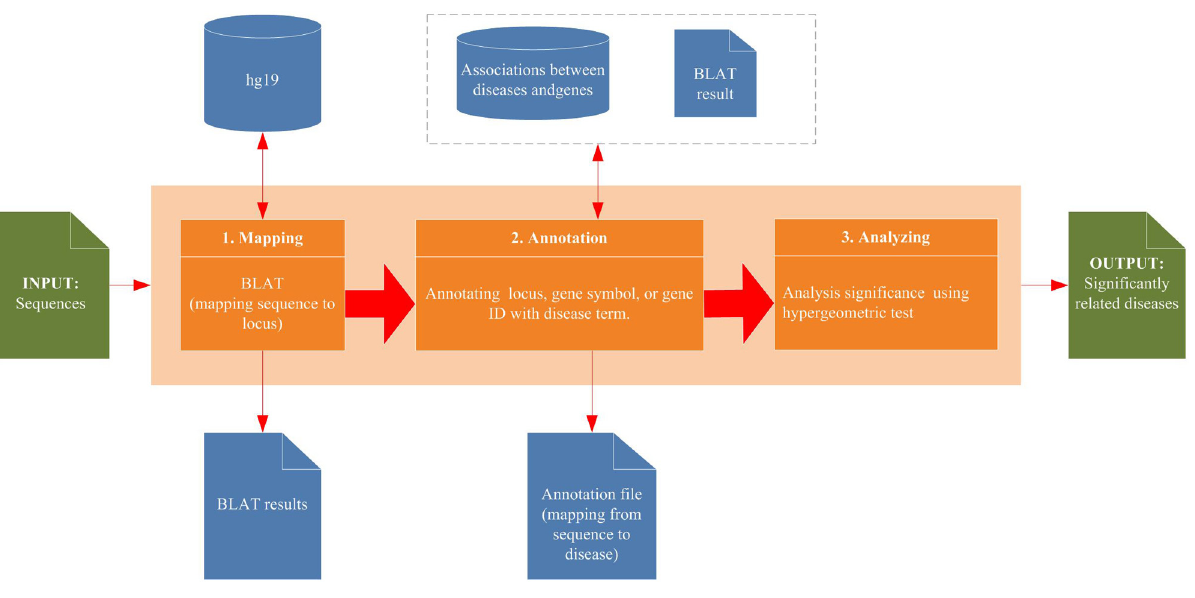
Fig 1. The process of